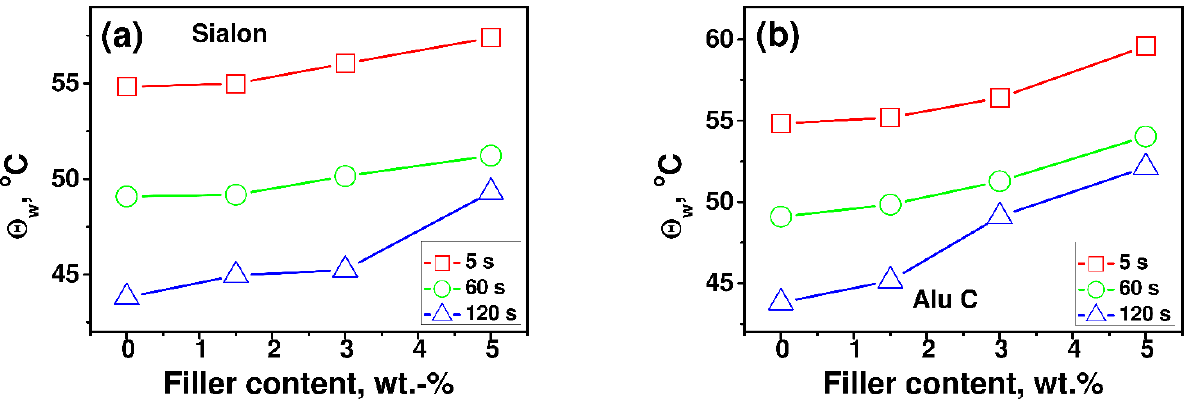
Figure 5. Scratch hardness for: ( a ) the first visible scratch (FVS) and ( b ) the first coating stripping (FCS) as a function of the Sialon and Alu C content in the coatings.